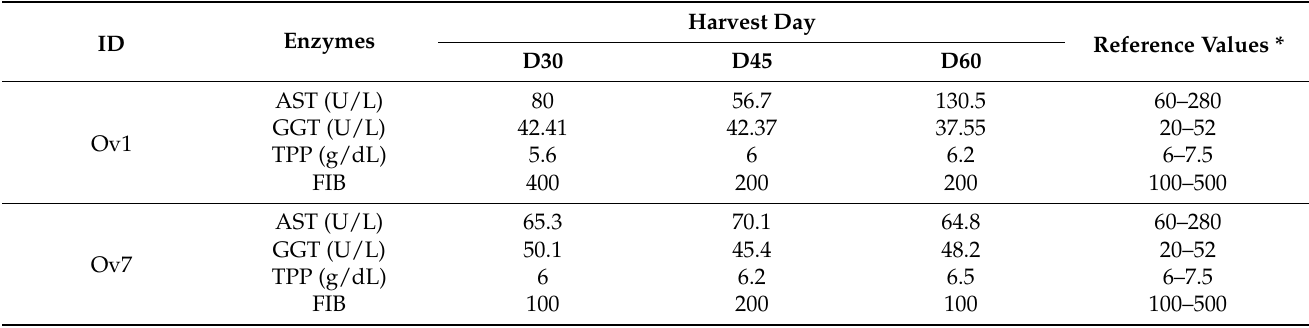
Table 4. Experimental poisoning by Chamaecrista serpens in sheep. Serum activity values of gamma- glutamyl transferase (GGT), aspartate aminotransferase (AST), total plasma protein (TPP) and fib- rinogen (FIB) of Ov1 and Ov7, in the recovery phase of intoxication by Chamaecrista serpens .